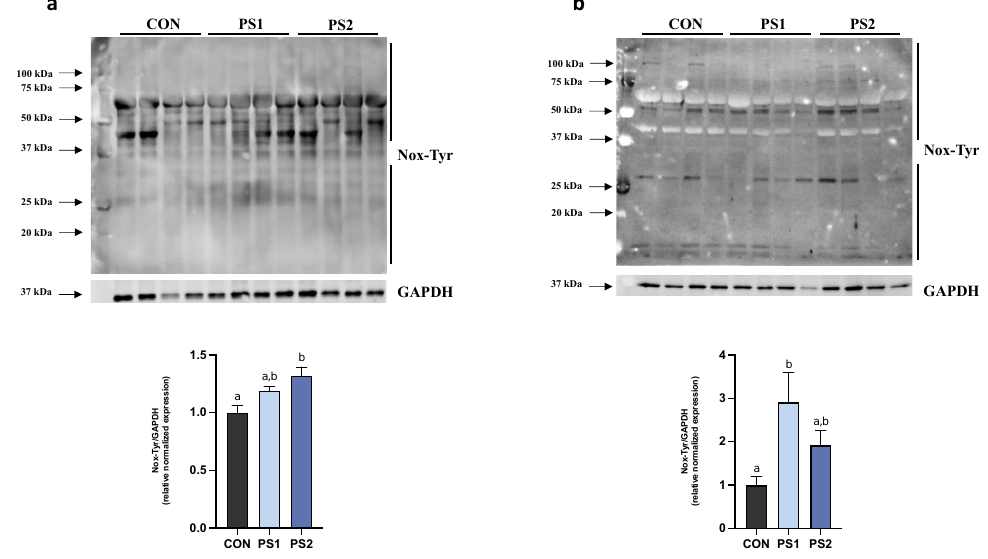
Figure 6. PS-MPs effect on nitrosylated proteins in anterior (AI) and posterior intestine (PI) of gilthead seabream. Western blot analysis for Nox-Tyr was performed in ( a ) AI and ( b ) PI of Sparus aurata after PS-MPs exposure. All data are shown as mean ± S.E.M. Different letters indicate significant differences among treatments (at least p < 0.05).